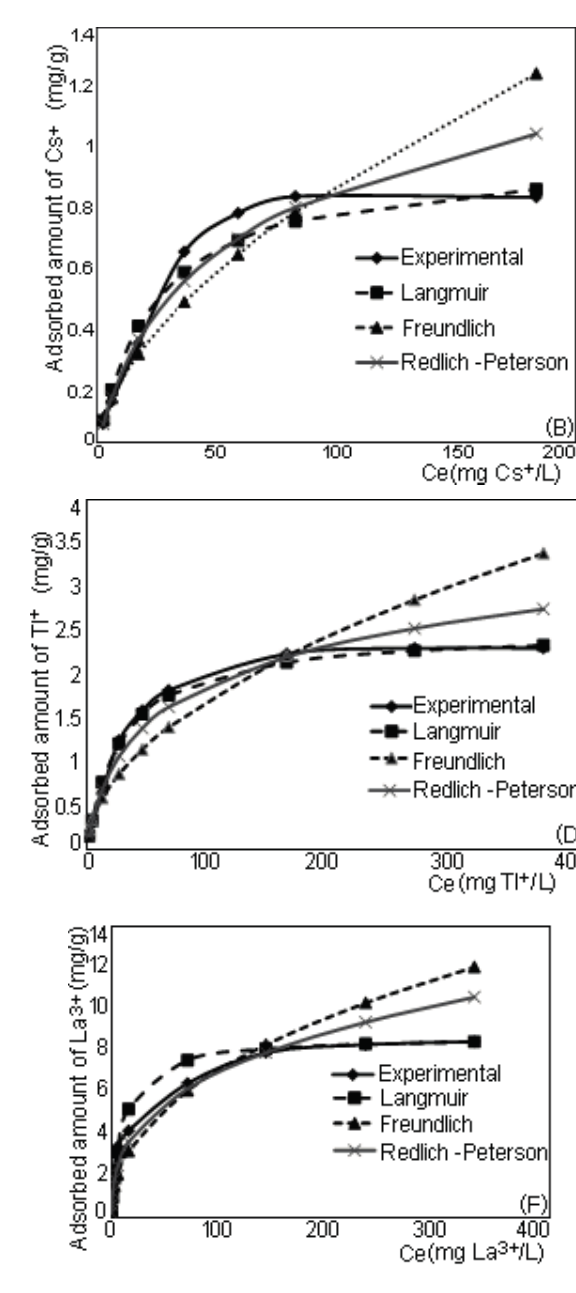
Figure 1. Experimental data and the sorption isotherm models for various metal ions adsorption onto ( E ) Eu(III), ( F )